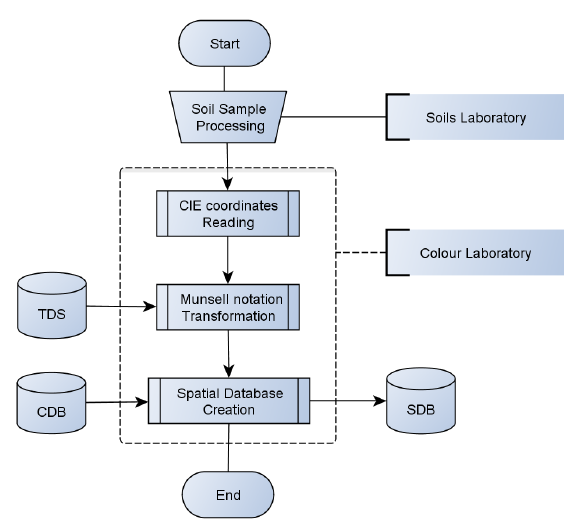
Figure 4: Flowchart of the procedure